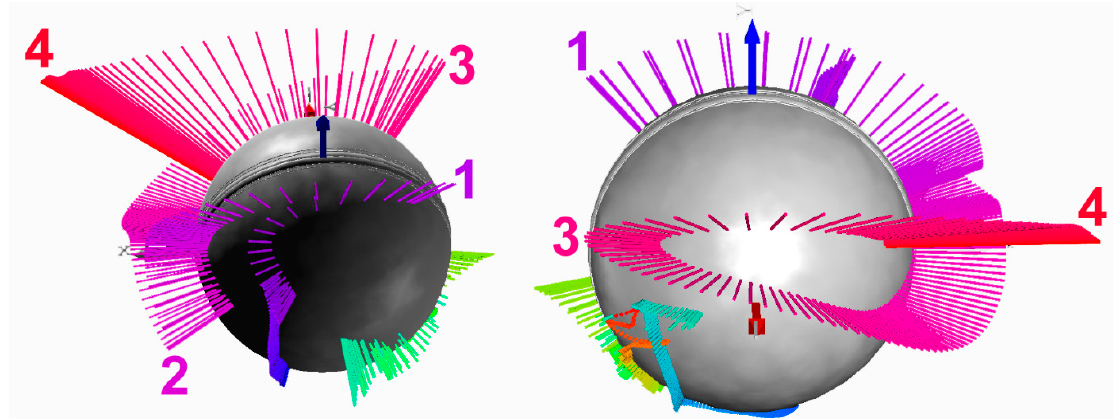
Figure 2. 4D spin axis (angular velocity) vector diagrams (the time as a 4th dimension is color coded) from 2 different aspects; 1, 2, 3 = change of direction of the spin axis; 4 = spin axis at release.